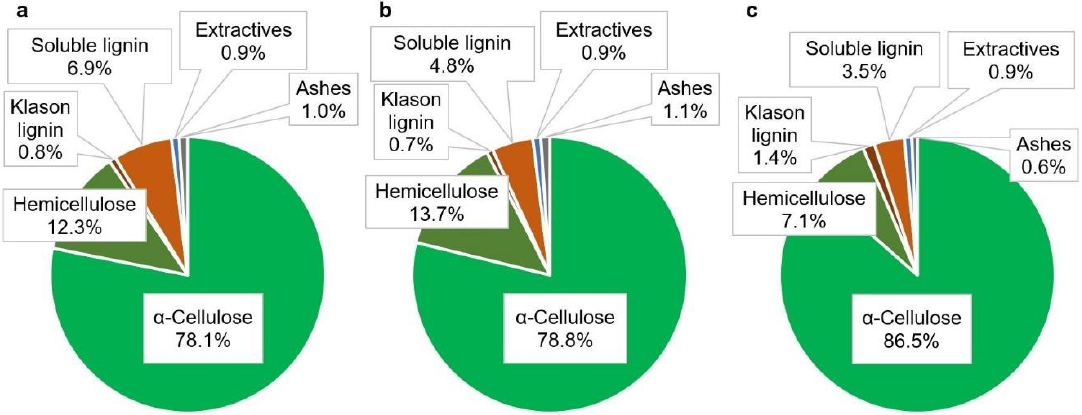
Figure 2. Chemical composition of the pulps from jute ( a ), sisal ( b ), and hemp ( c ).